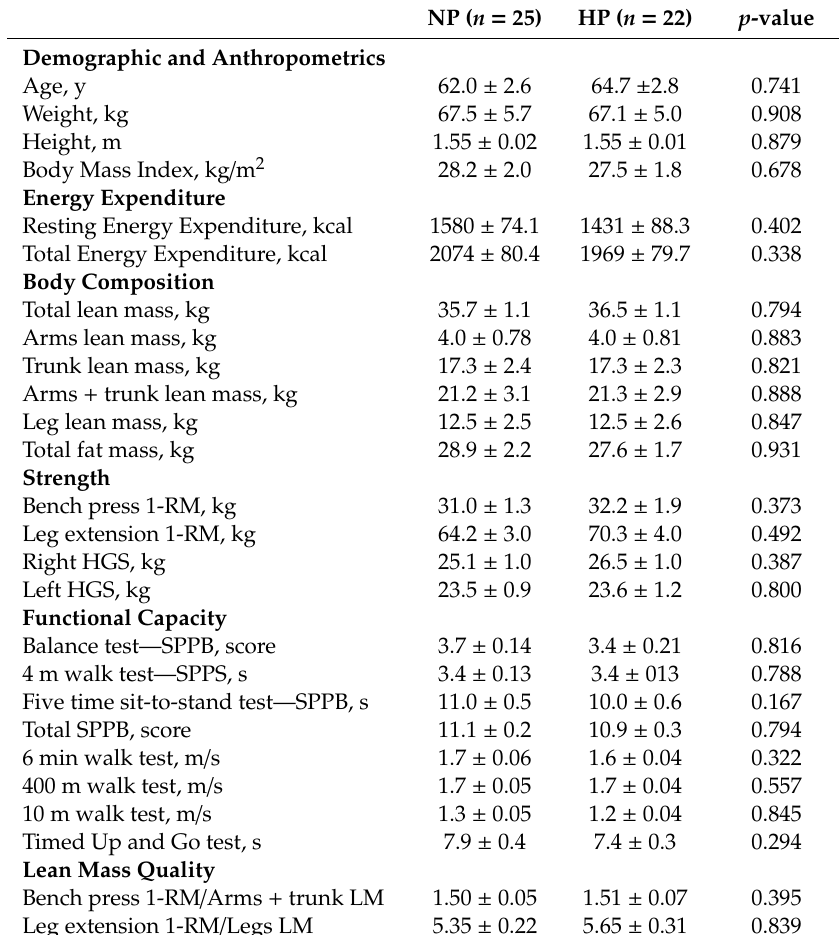
Table 1. Baseline characteristics of the